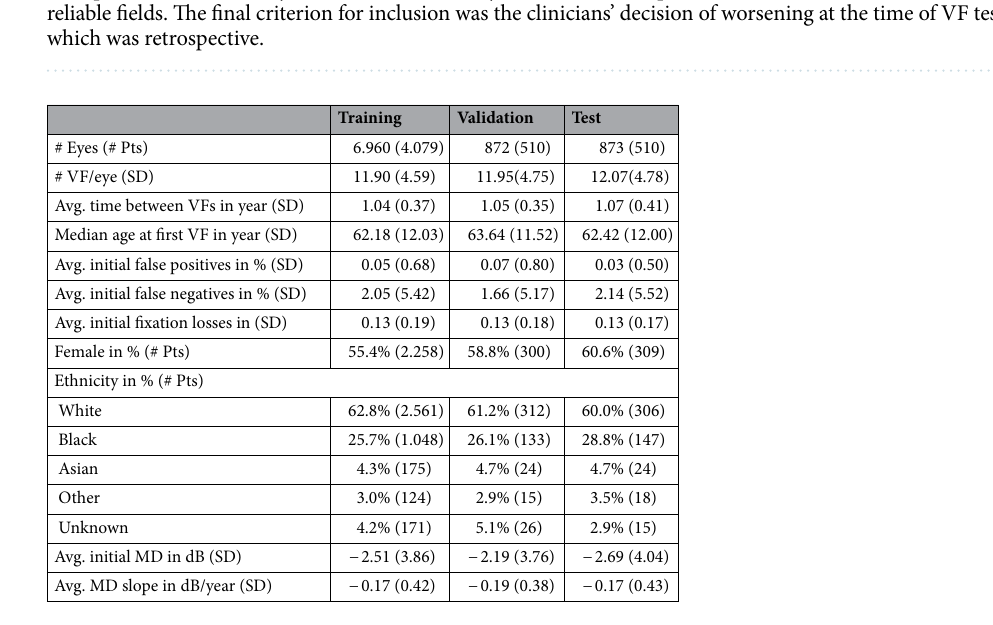
Table 1. Demographic and visual field characteristics of eyes included in this study.